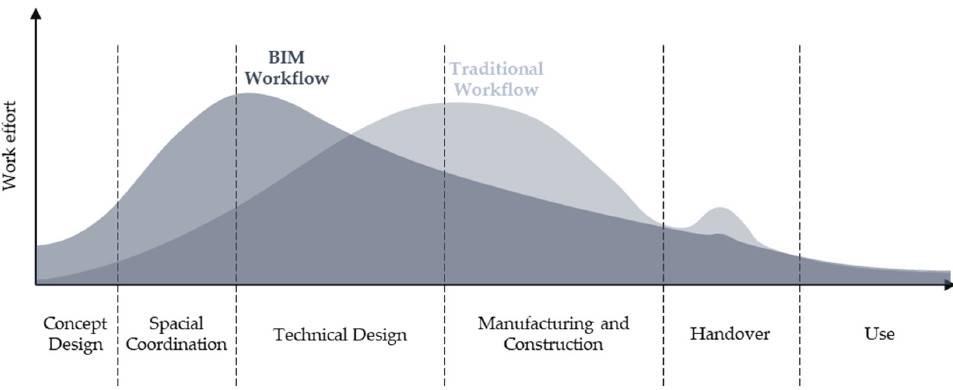
Figure 4 Figure 4. Effort distribution on the life cycle phases in the traditional workflow compared to the BIM workflow